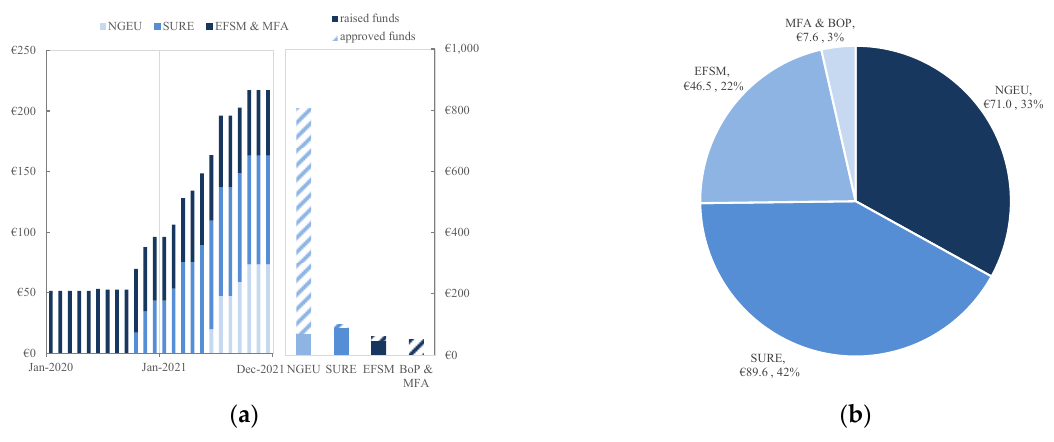
Figure 1. EU debt and programs. ( a ): Total outstanding debt by EU program in EUR bn between January 2020 and December 2021. NGEU and SURE are COVID-19-related recovery initiatives. EFSM refers to the European Financial Stability Mechanism. MFA refers to Macro-Financial Assistance to non-EU countries. BOP refers to the EU’s Balance of Payments program. ( b ): EU debt in billion EUR and as percentages of total outstanding debt in December 2021.